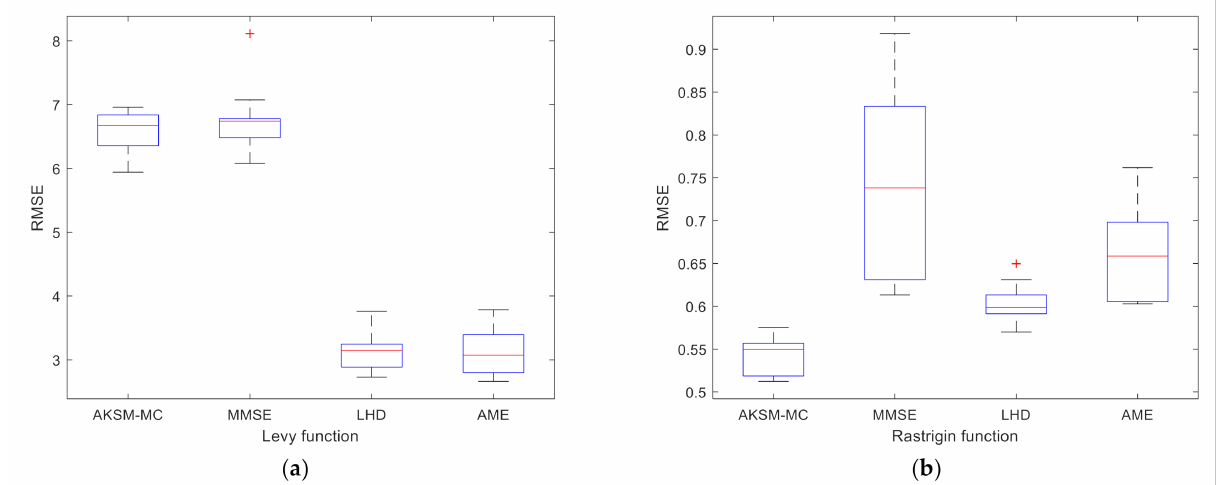
Figure 10. ( a ) Box plot of test results for Levy function; ( b ) Box plot of test results for Rastrigin function.